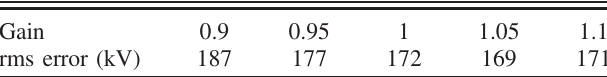
TABLE V. rms error with feedforward gain (feedback on) and wider bandwidth, lower gain OTFB.